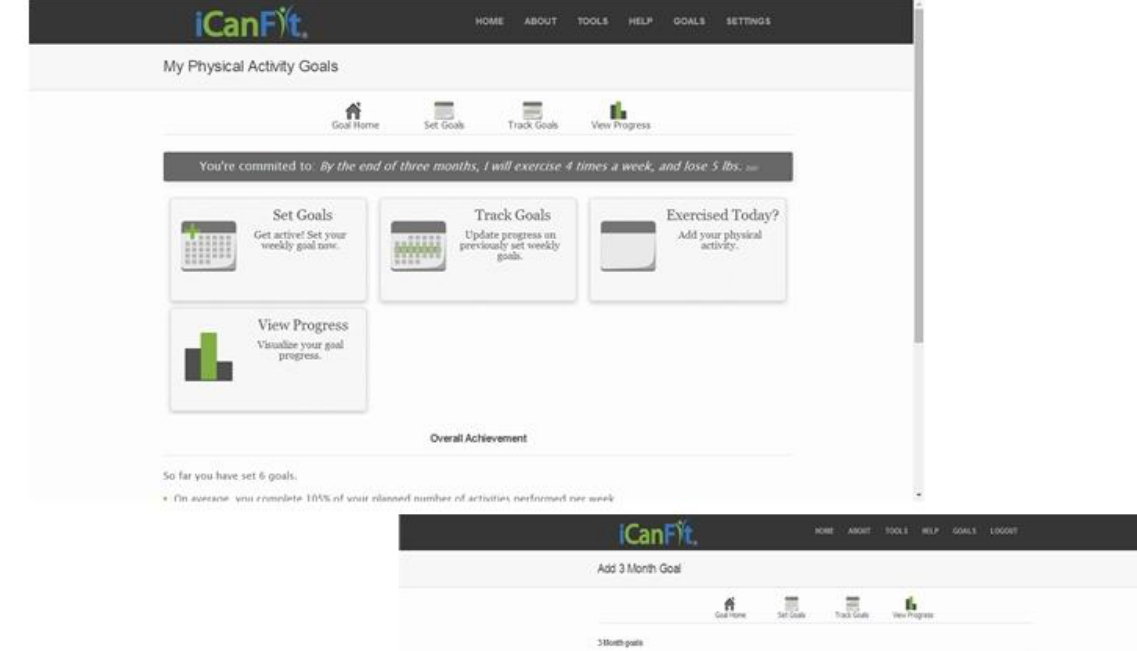
Figure 2. Goals function in